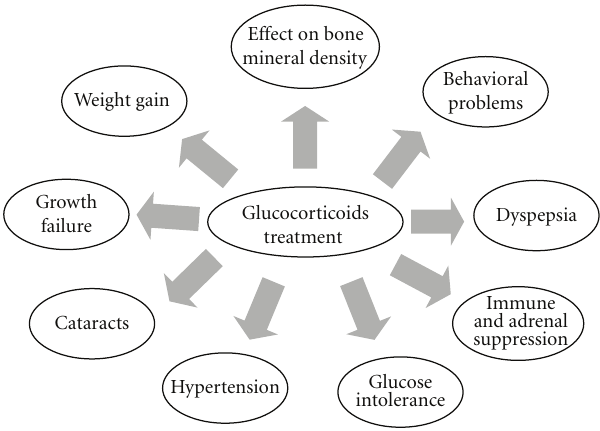
Figure 2: Side e ff ects of glucocorticoid treatment in muscular